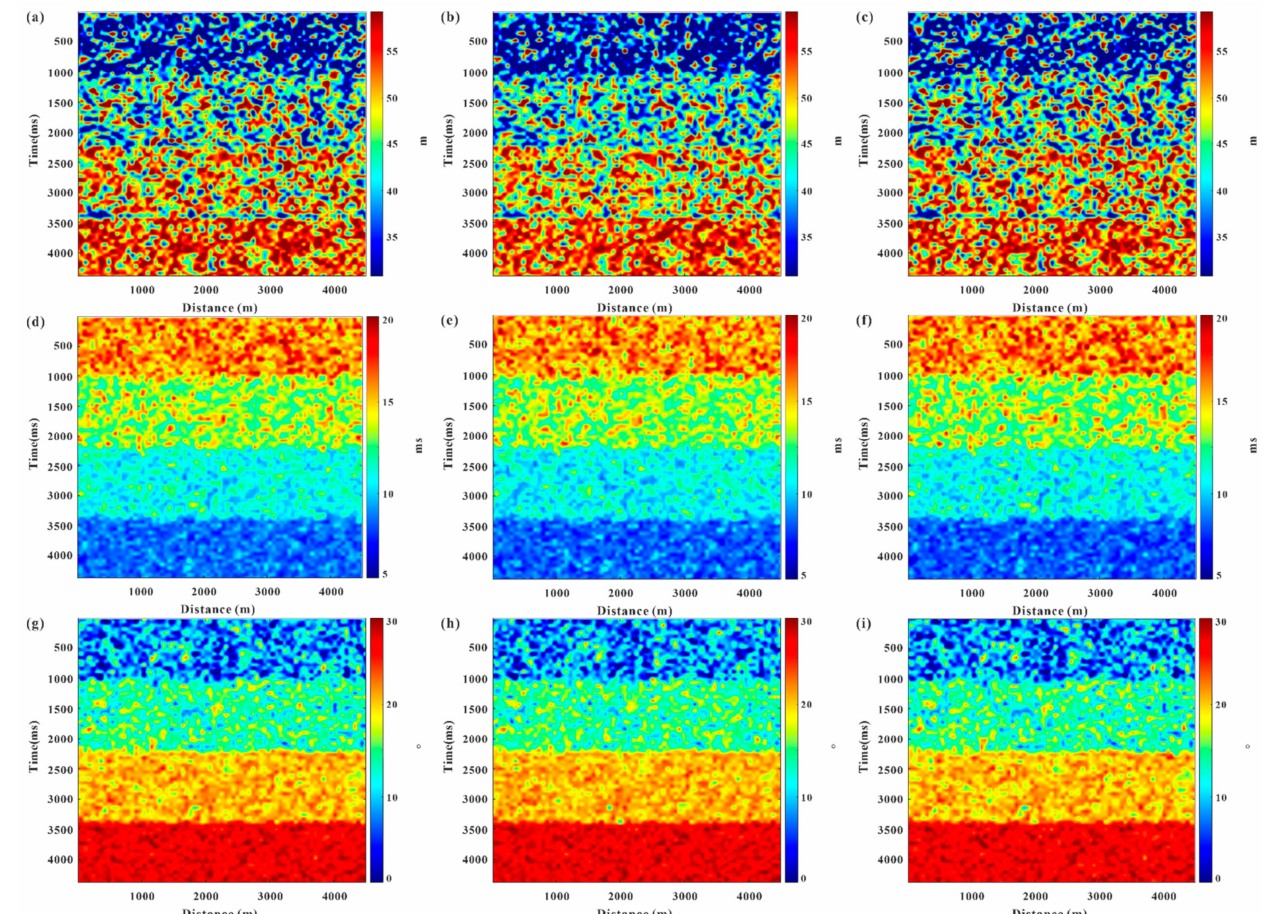
Figure 6. Estimation results of autocorrelation parameters of porosity, clay volume, and water saturation: ( a – c ) are the horizontal autocorrelation length of porosity, clay volume, and water saturation, respectively. ( d – f ) are the vertical autocorrelation length of porosity, clay volume, and water saturation, respectively. ( g – i ) are the autocorrelation angles of porosity, clay volume, and water saturation, respectively.